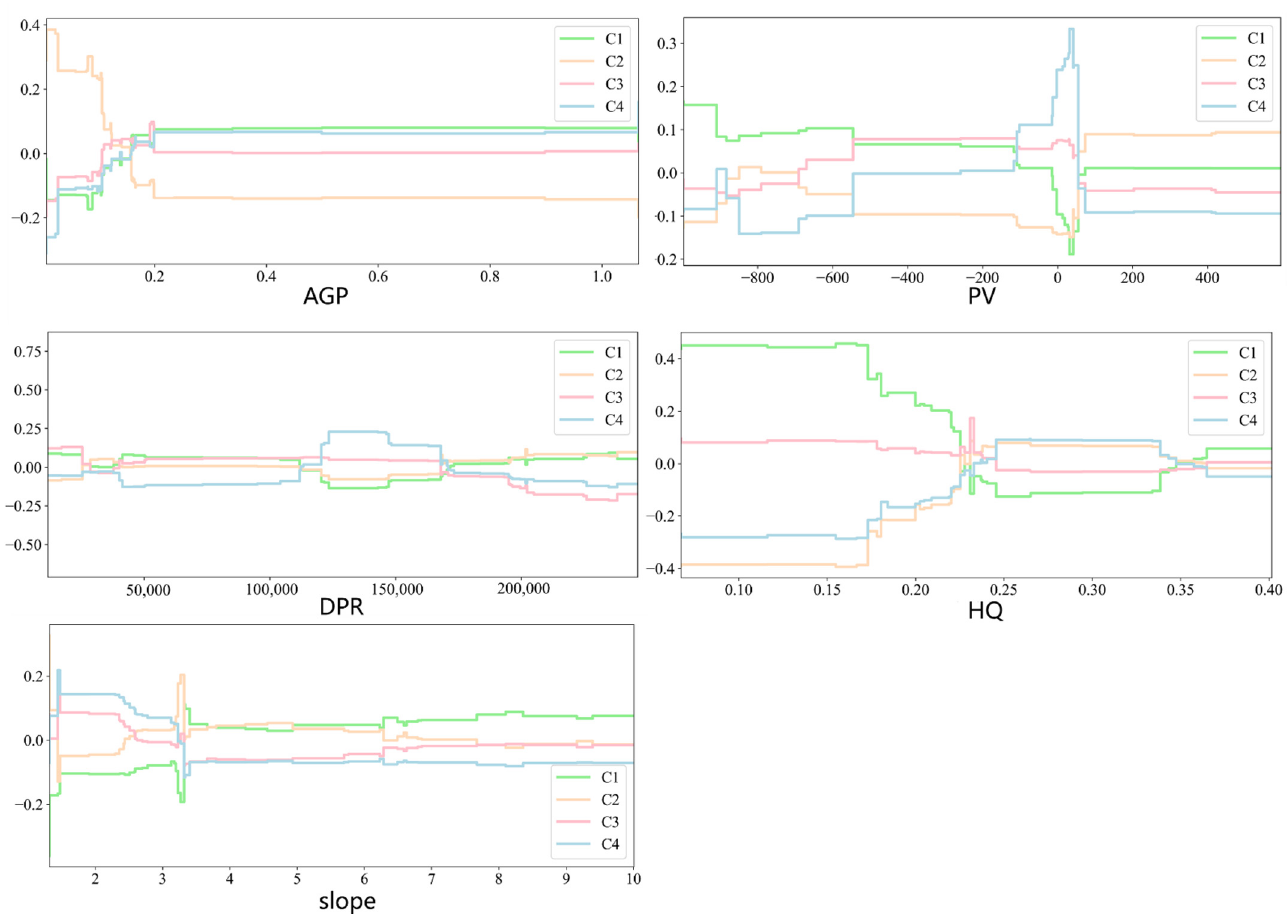
Figure 9. MC-EBM results between top five key variables and matching modes (C1: SD, C2: WED, C3: RWD, C4: SND).